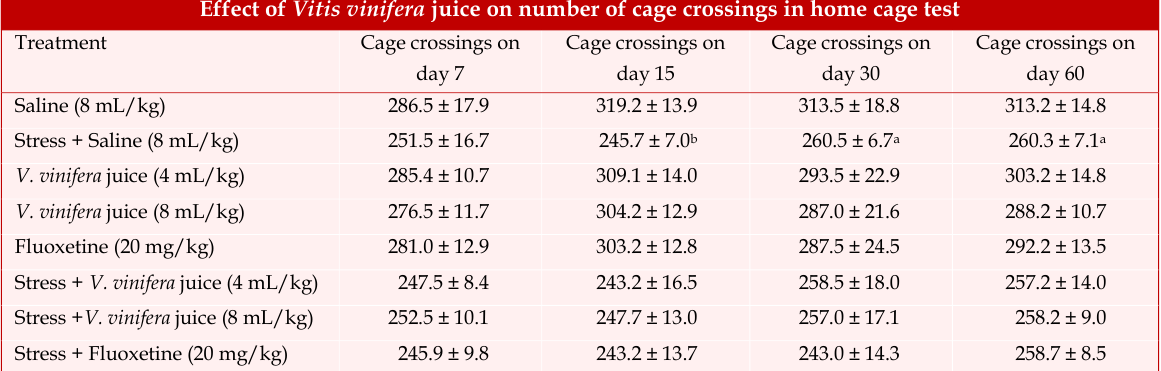
Effect of Vitis vinifera juice on number of cage crossings in home cage